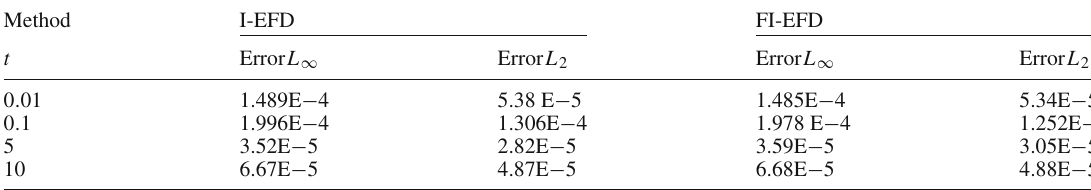
Table 9 L ∞ and L 2 errors of Example 5.3 for (cid:2) x = 0 . 05 and (cid:2) t = 10 − 4 Method t 0 .